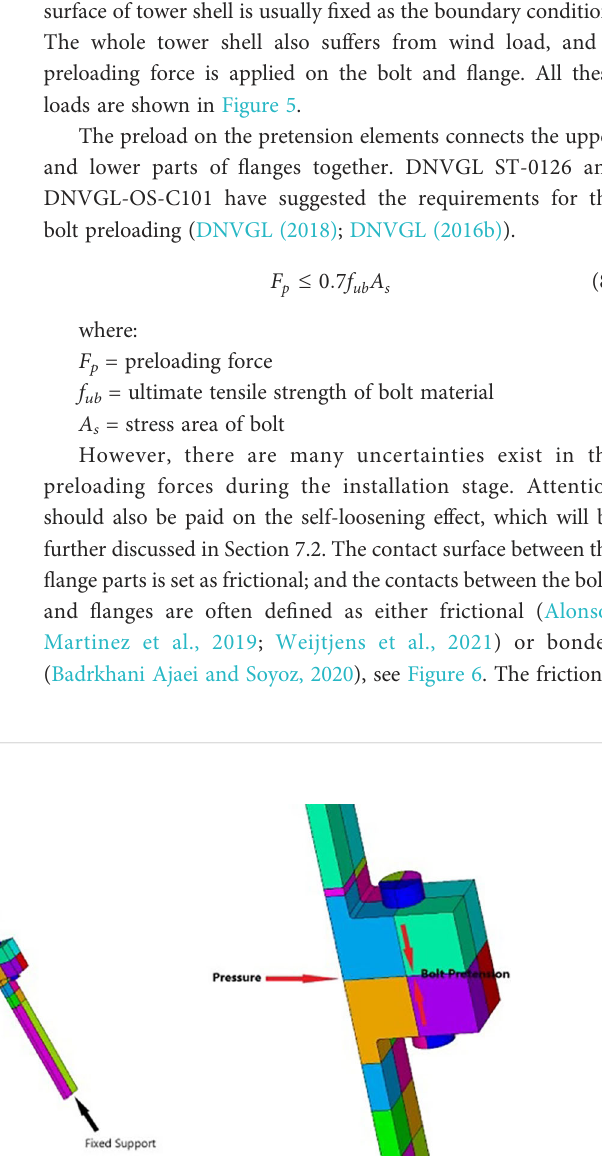
FIGURE 5 Finite element model of ring shape fl anges (left); local model of fl anges and its boundary conditions